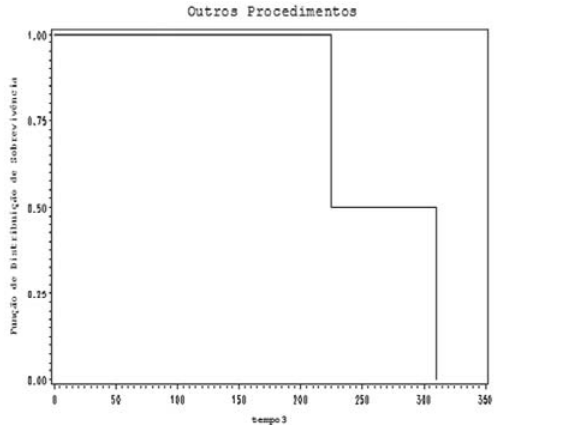
Fig. 7 - Sobrevivência por Tipo: Valvares - tempo 3: T3 - Tempo da Presença do Doente na Sala de Operação (minutos)